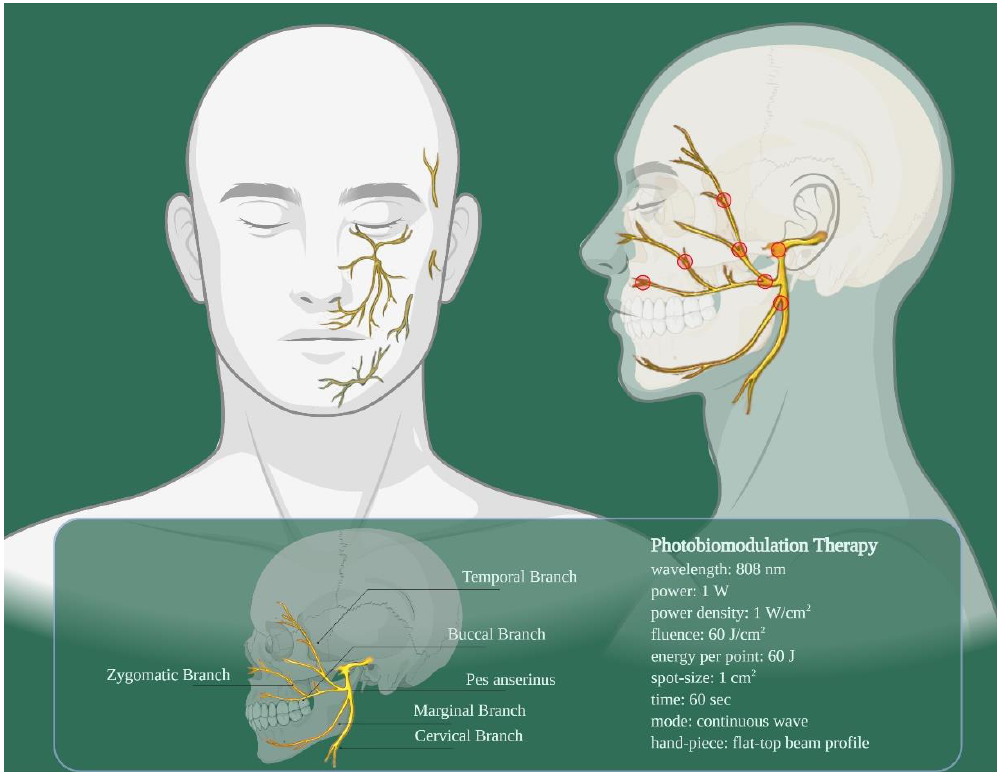
Figure 2. Design of the photobiomodulation therapy irradiation area and parameters. In yellow, the frontal and lateral representations of the facial nerve and its branches. The red circles along the facial nerve branches indicate the points where the therapy was administered in every session. Image created with BioRender.com.